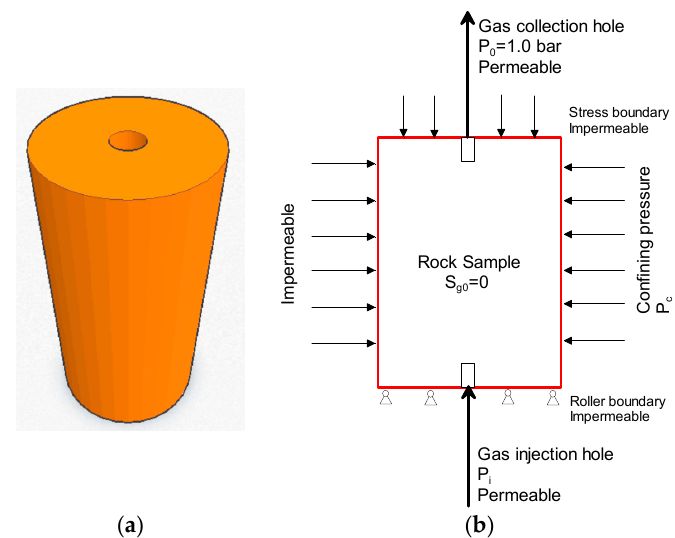
Figure 8. Test sample ( a ) 3D view and ( b ) cross-section with boundary conditions.